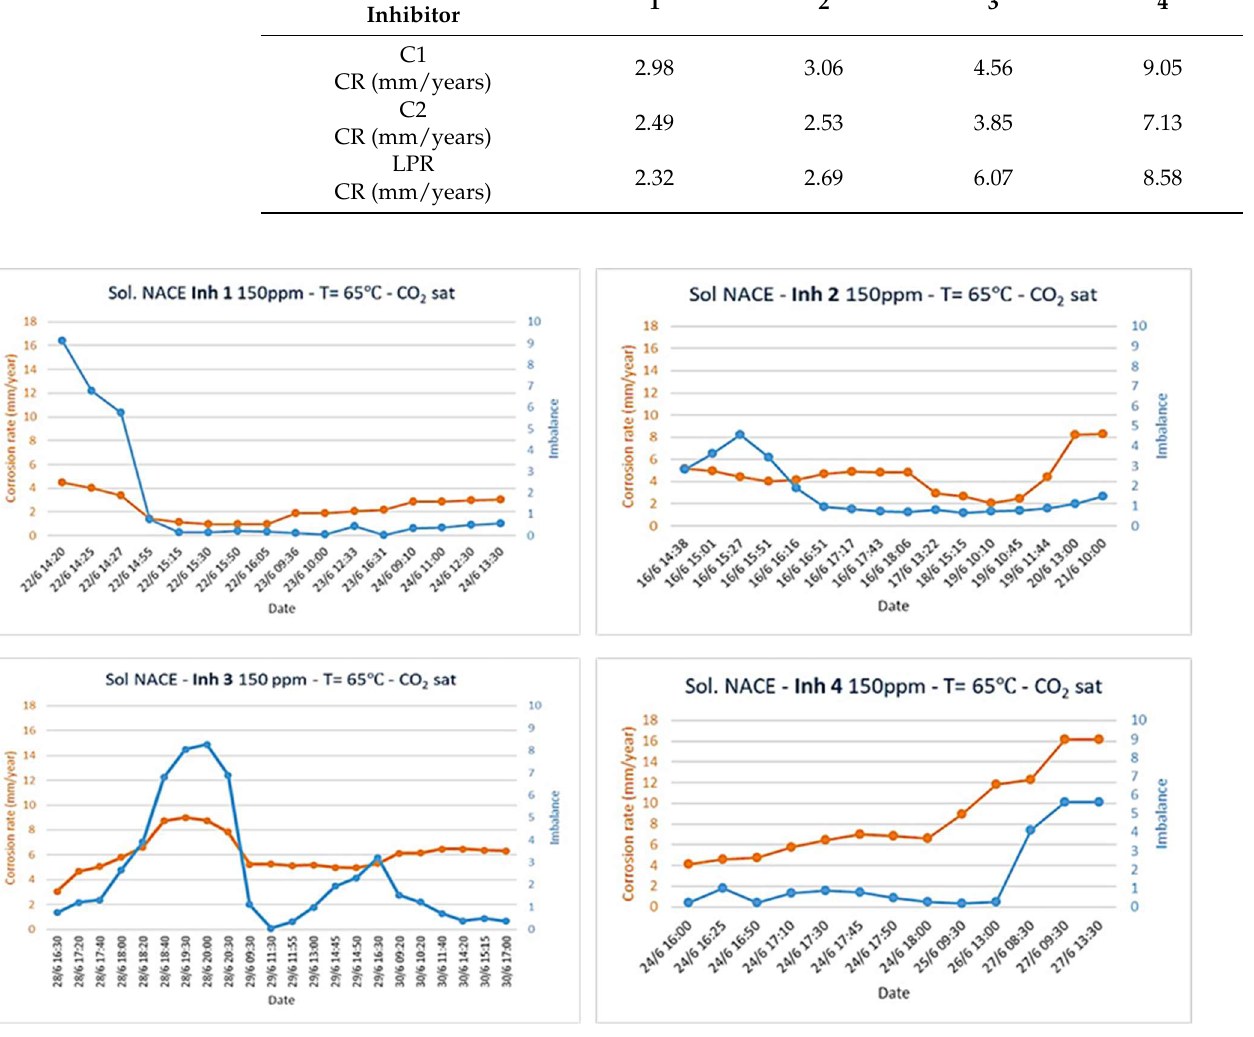
Figure 4. Curves obtained from each test. The x -axis shows the period of time, whereas the left y -axis shows the CR and the right y -axis shows the imbalance values.